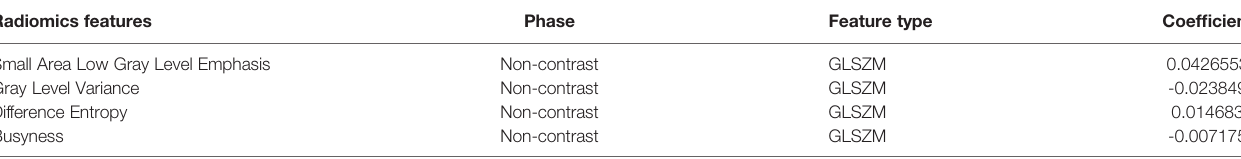
TABLE 2 | LASSO coef fi cient pro fi les of the 4 features. Radiomics